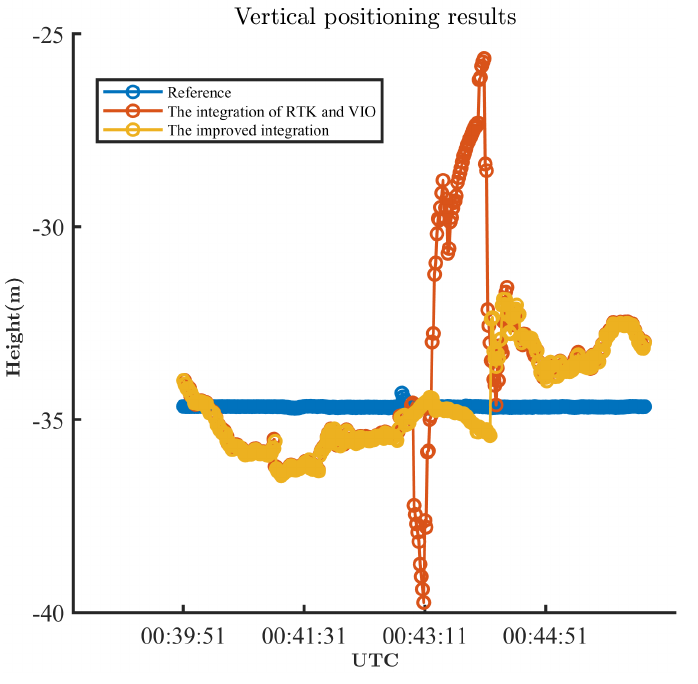
Figure 18. Vertical positioning results. Table 7. Positioning results’ deviations.